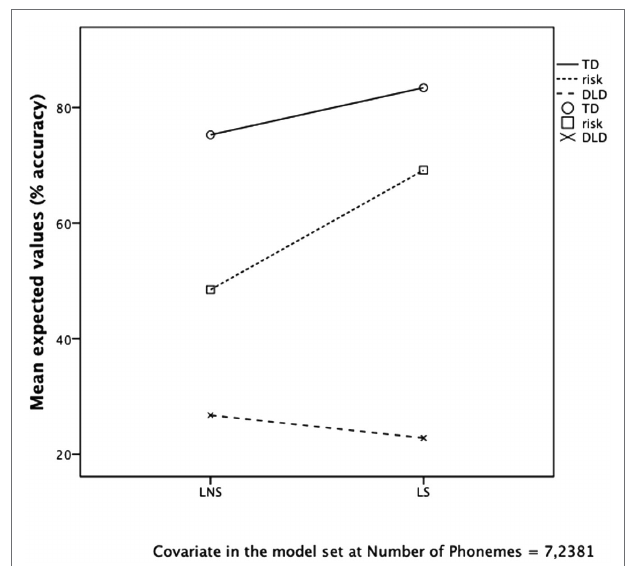
FIGURE 3 | Children’s mean percentage of correctly repeated LNS (language-non-specific, n = 9) vs. LS (language-specific, n = 11) NWs in the MuLiMi NWRT according to their clinical risk status (TD, at-risk, or